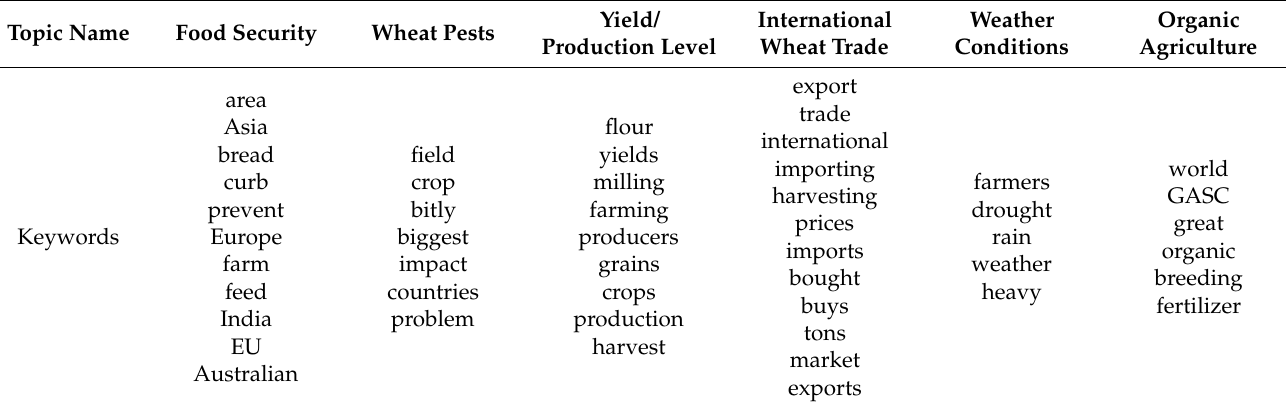
Table 2. Primary topics of the wheat grain related tweets